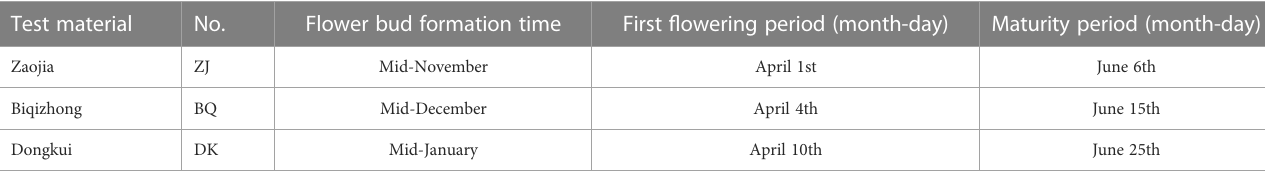
TABLE 1 Phenological periods of different test